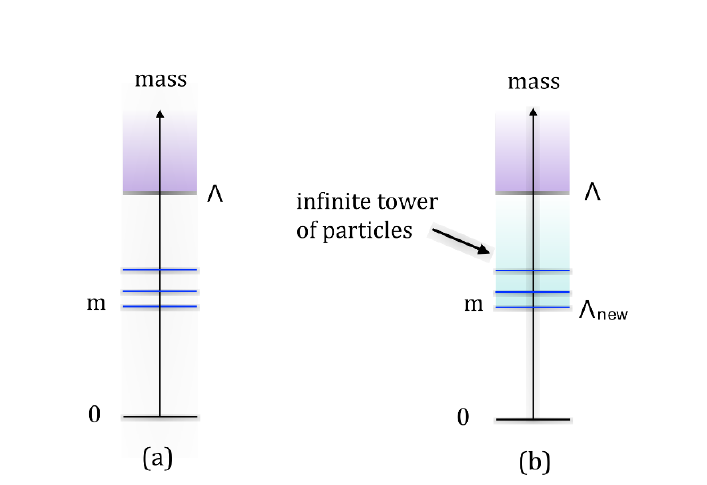
Figure 1 . Spectrum of elementary particles with spin J > 2 in a theory where the dynamics of gravitons is described by the Einstein-Hilbert action at energy scales E (cid:28) (cid:3). The cut-o(cid:11) scale (cid:3) can be the string scale and hence there can be an in(cid:12)nite tower of higher spin particles above (cid:3). Figure (a) represents a scenario that also contains a (cid:12)nite number of higher spin particles below the cut-o(cid:11) and hence violates causality. Causality can only be restored if these particles are accompanied by an in(cid:12)nite tower of higher spin particles with comparable masses which is shown in (cid:12)gure (b). This necessarily brings down the cut-o(cid:11) scale to (cid:3) new = m , where m is the mass of the lightest higher spin